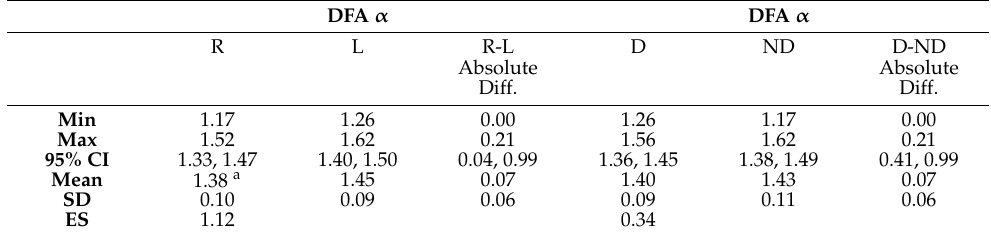
Table 3. Summary statistics and effect sizes for detrended fluctuation analysis α (n = 16).